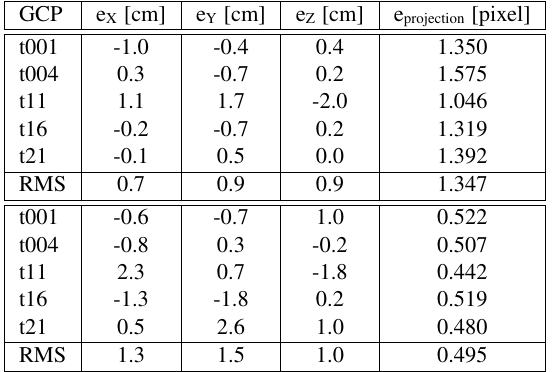
GCPs error RMS obtained by just the rectangular and circular flight plans are almost equal while the projection errors shows to be different, as shown in Table1.